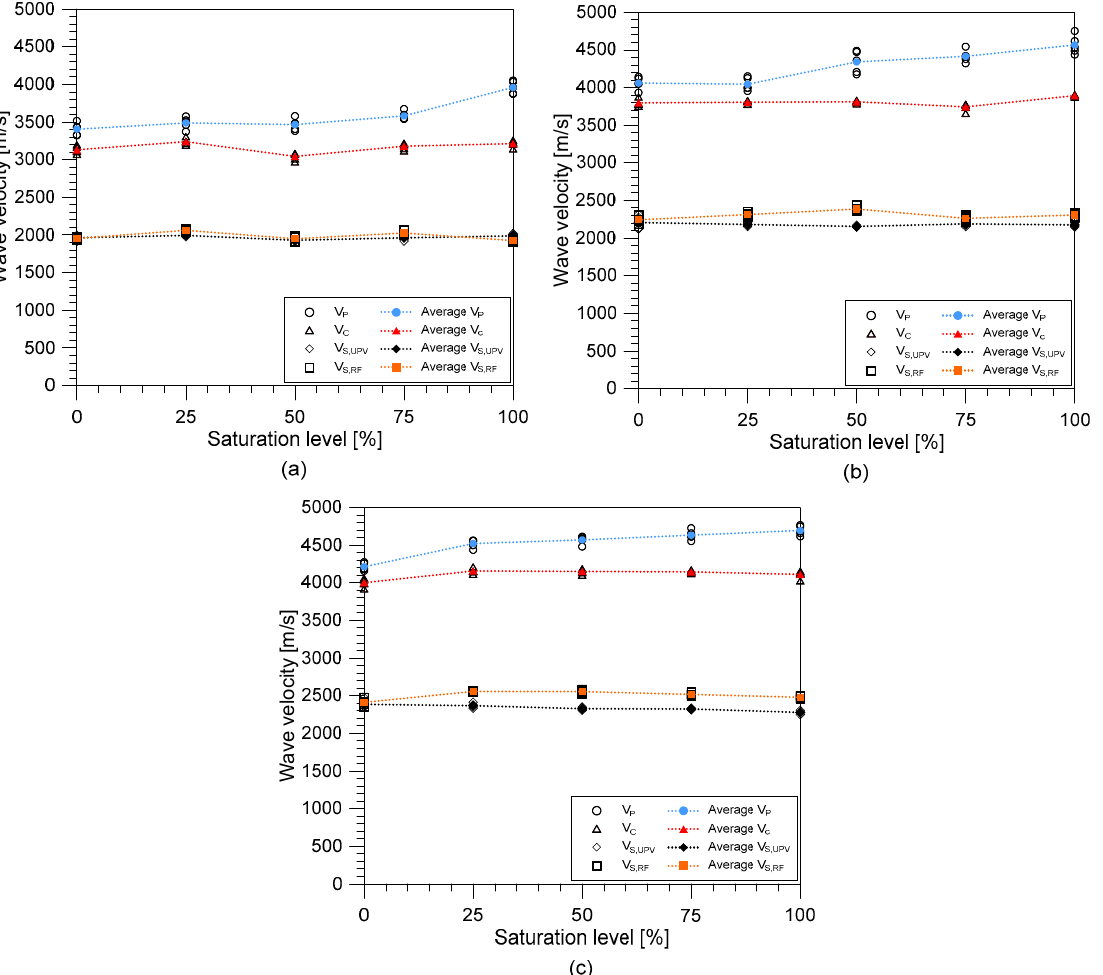
Figure 9. Variation of the three wave velocities (constrained compressive wave velocity, V P , unconstrained wave velocity V C , and shear wave velocity, V S,UPV and V S,RF ) of submerged concrete as the water saturation increases measured from concrete with: ( a ) MIX 1, ( b ) MIX 2, and ( c ) MIX 3.